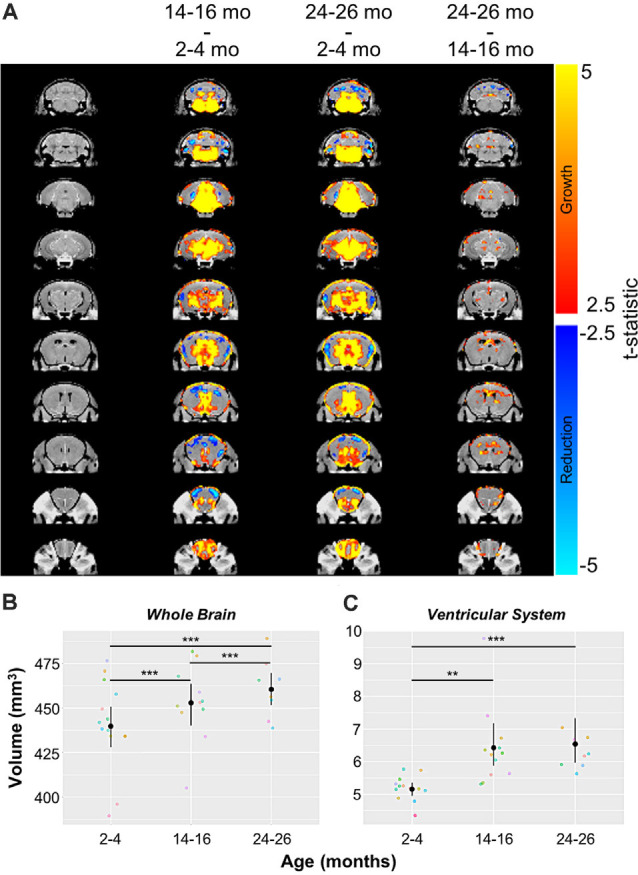
Volumetric changes in the whole brain and ventricular system over aging. (A) Deformation maps of global voxel-wise volumetric changes between 2–4 months, 14–16 months, and 24–26 months datasets with significance calculated per voxel with a false discovery rate <5%. Volumetric analyses of (B) the whole brain and (C) the ventricular system (the compiled lateral ventricles, third ventricle, cerebral aqueduct, and fourth ventricle). Symbol colors in (B,C) represent distinct mice and error bars represent the 95% confidence intervals. Separately, one-way analysis of variance (ANOVA) revealed a significant change in volume with age over the 2-year period for both the whole brain and ventricular system (***p < 0.001). Results of Tukey’s HSD post hoc test between age groups are shown, where **p < 0.01, and ***p < 0.001.